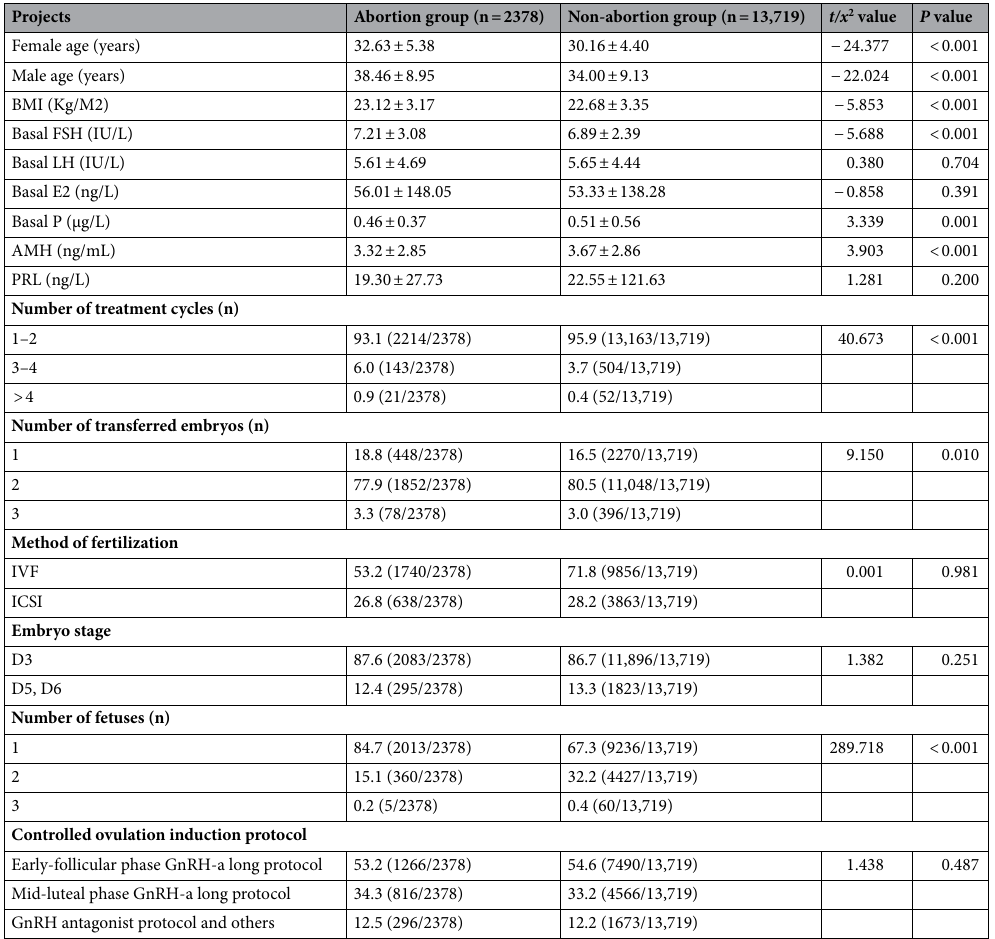
Table 1. Comparison of baseline data between spontaneous abortion group and non-abortion group. Data are shown as means ± standard deviation or N(%). BMI, body mass index; FSH, follicular-stimulating hormone; LH, luteinizing hormone; E2, estradiol; P, progesterone; AMH, anti-Mulller hormones; PRL, prolactin; IVF, in vitro fertilization; ICSI, intracytoplasmic sperm